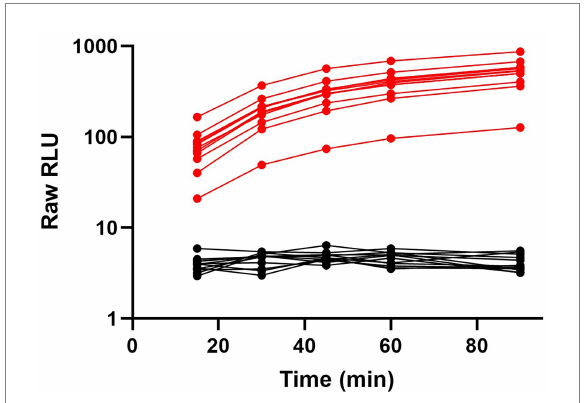
FIGURE 7 Ternary Nluc-based assay for SARS-CoV-2 antibody response in serological samples. Serum samples from convalescent SARS- CoV-2 patients ( n = 13) in red or pre-pandemic patients ( n = 12) in black were individually tested with the lyophilized, all-in-one ternary Nluc serology assay. Samples were measured at 15, 30, 45, 60, and 90-min intervals with a handheld